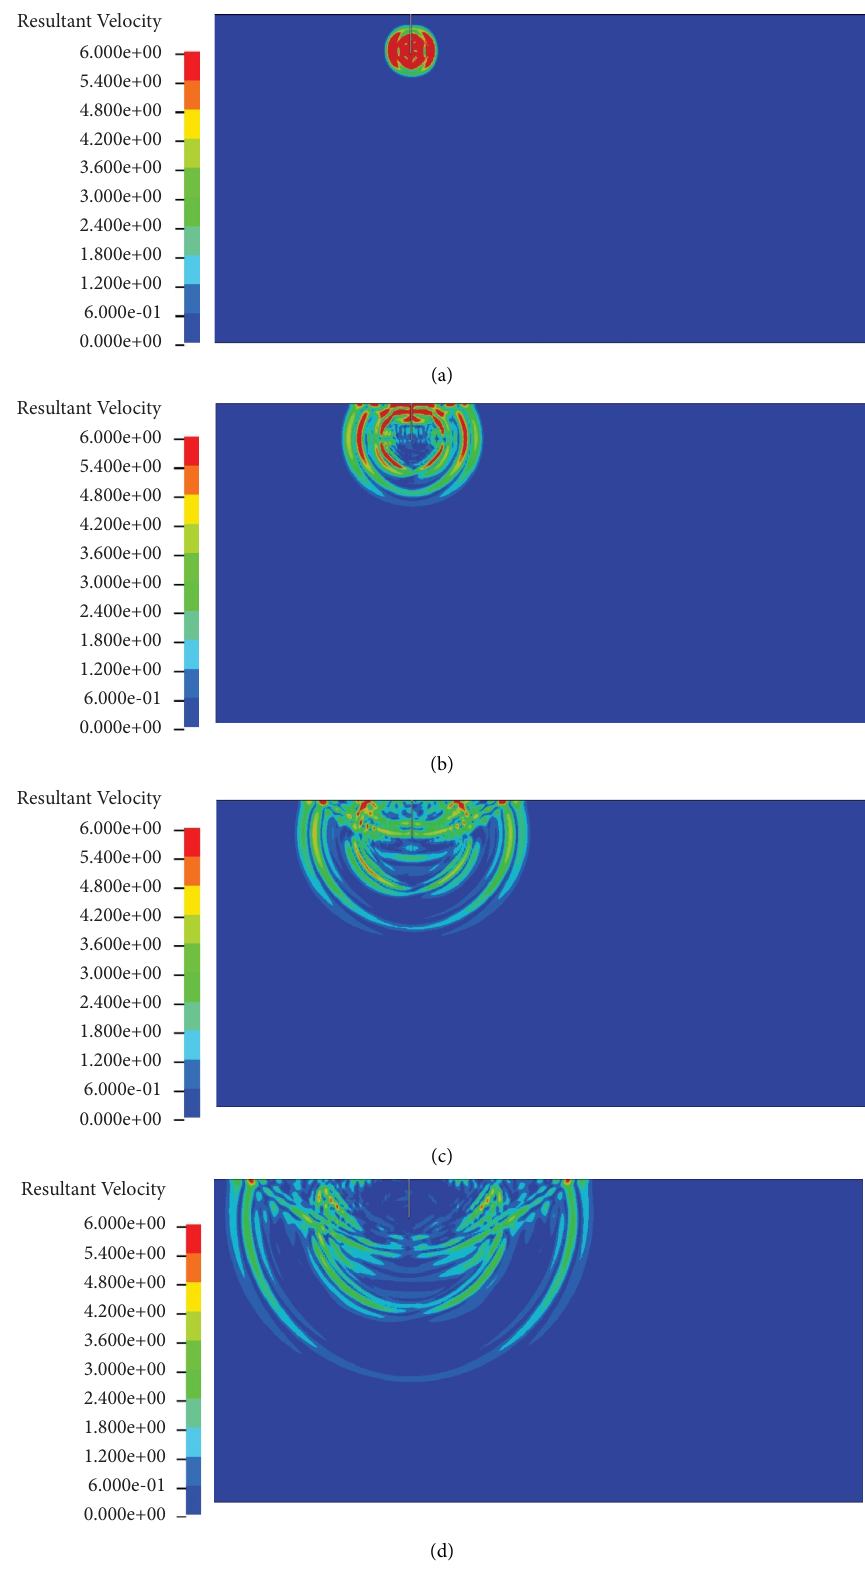
Figure 2: Propagation characteristics of vibration resultant velocity without vibration-isolating slot. (a) Time � 1ms. (b) Time � 3 ms. (c) Time � 5ms. (d) Time �